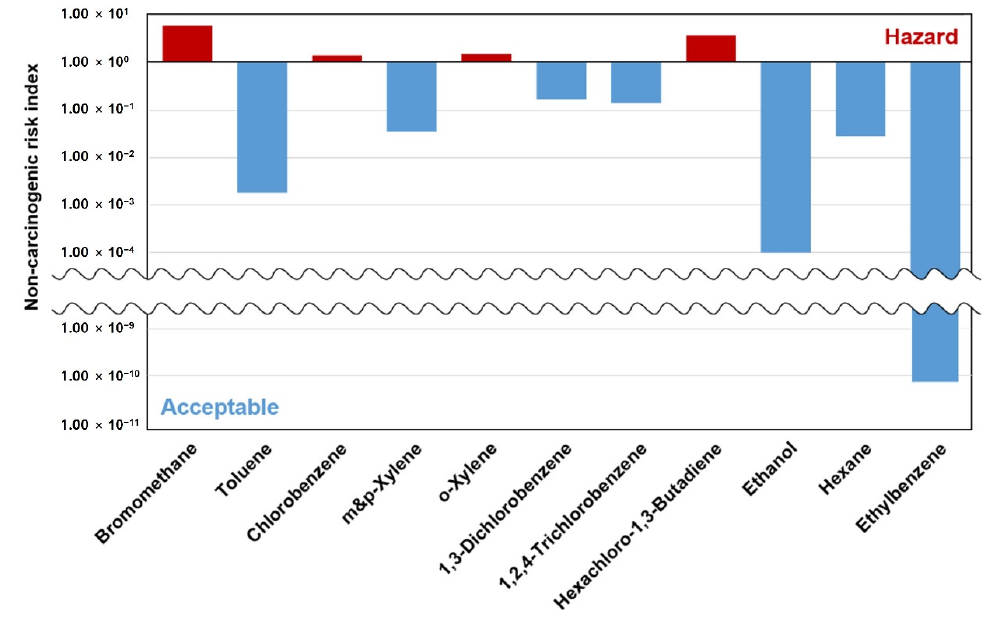
Figure 6. Risk assessment result of toxic non-carcinogenic VOCs.